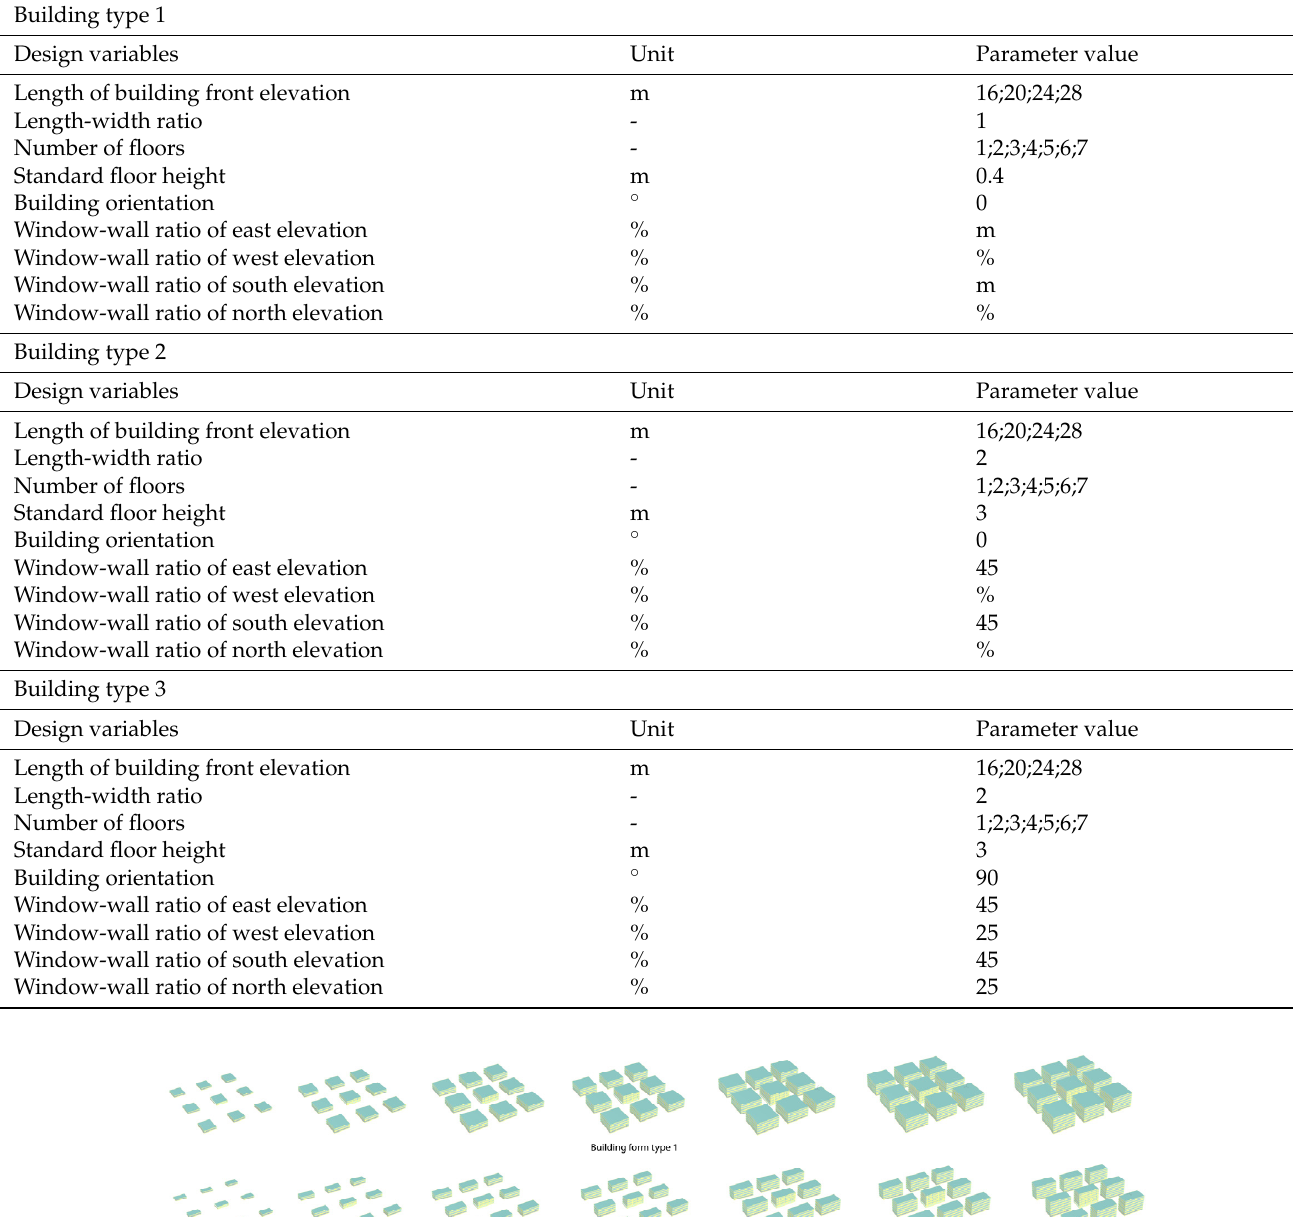
Table 13. Parameter setting of building forms for low-rise and medium-rise residential buildings.